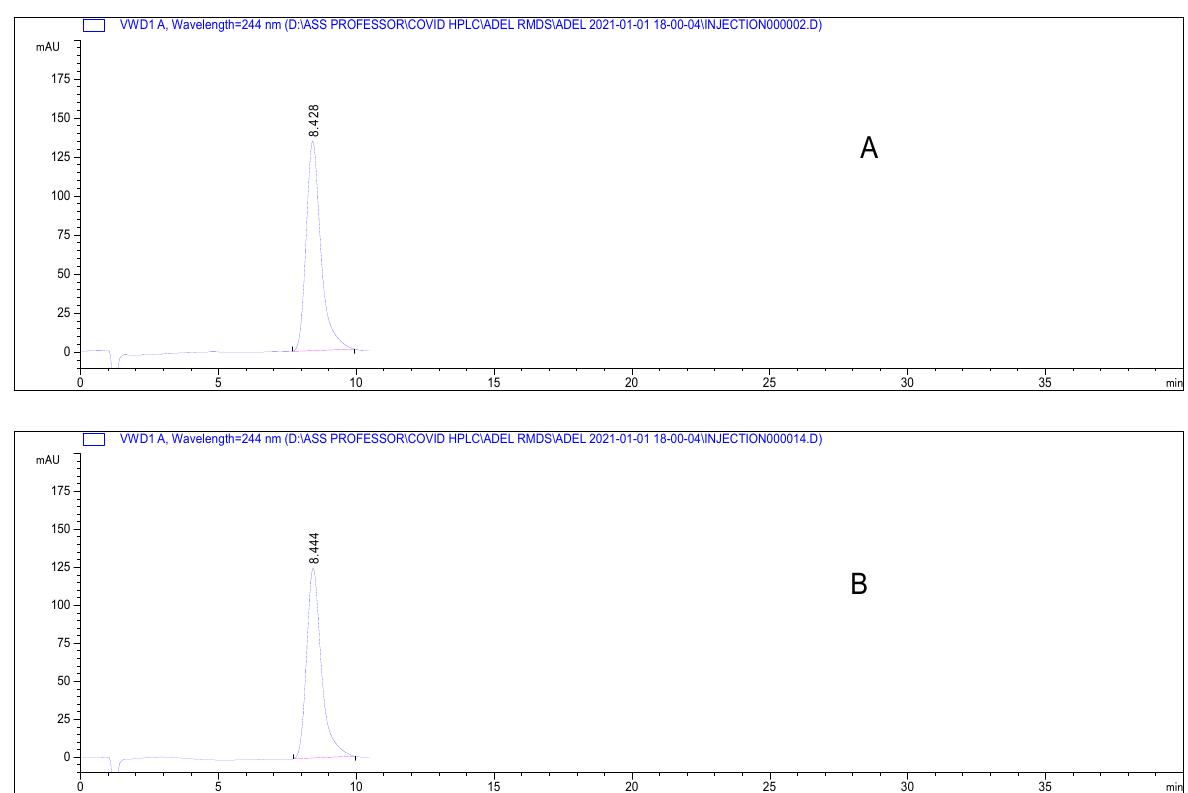
Figure 2. Chromatograms presenting elution of RDS ( A ) pure form (80 µ g mL − 1 ), ( B ) diluted Remdesivir-Rameda ® IV infusion under the proposed chromatographic conditions.